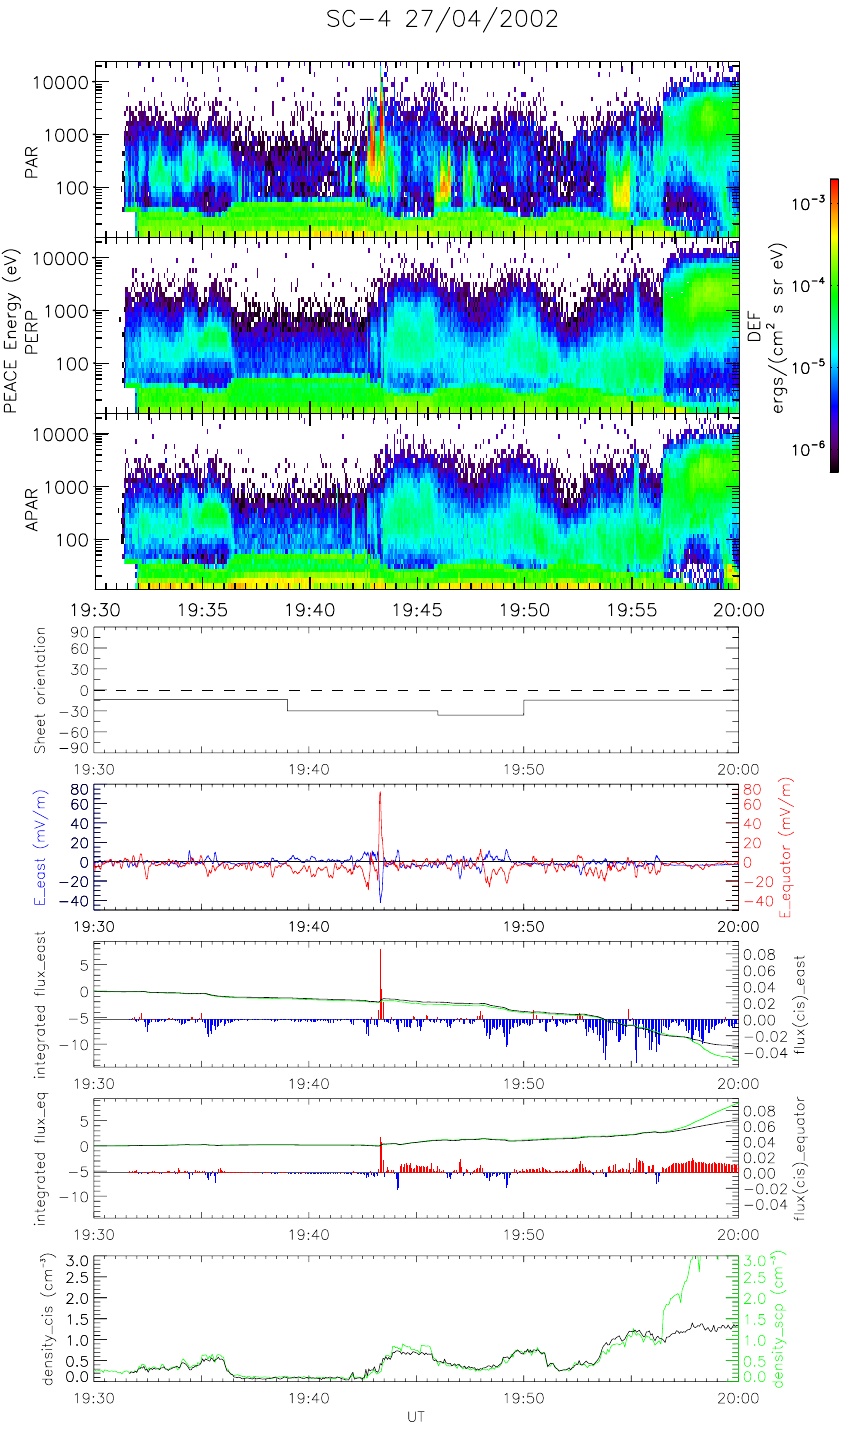
Fig. 2. Measurements by Cluster spacecraft 4 from a southern auroral oval crossing on 27 April 2002. The panels are in the same format as Fig.